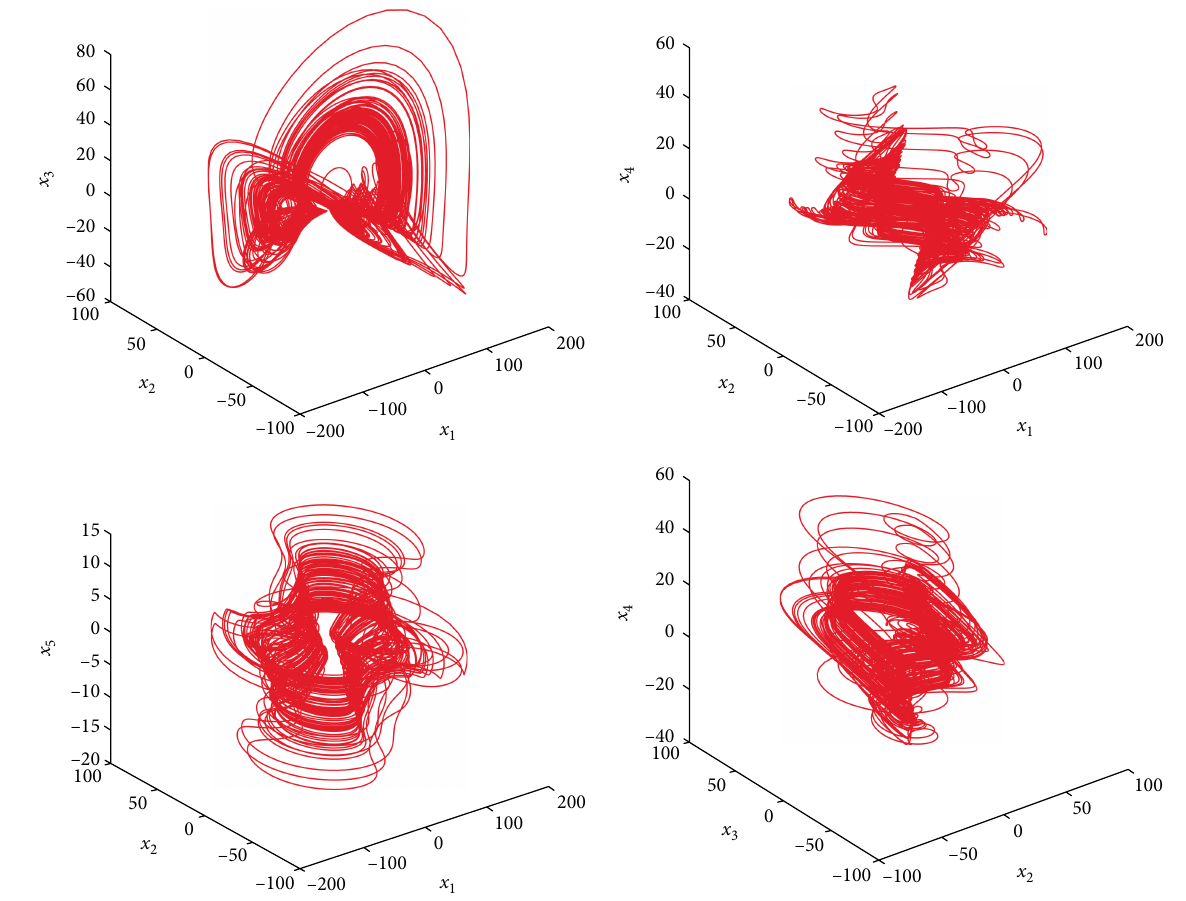
Figure 3: 3D phase portraits of the hyperchaotic